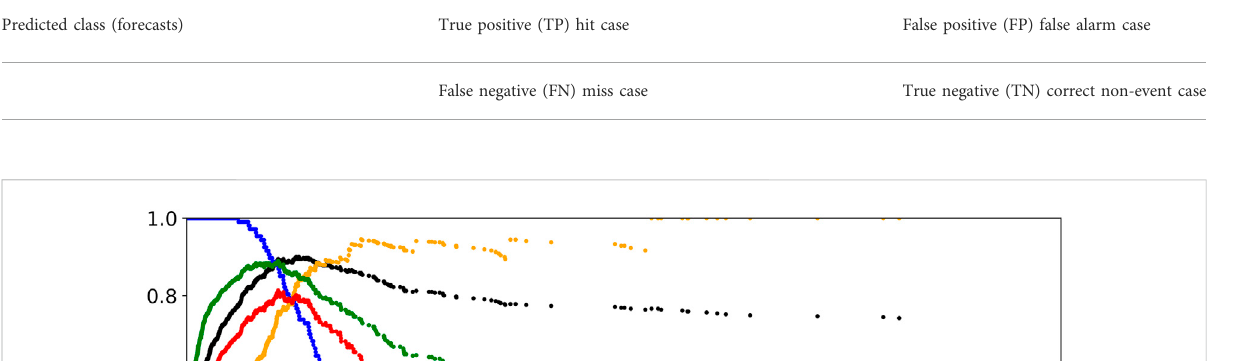
TABLE 1 Confusion matrix for binary classi fi cation.